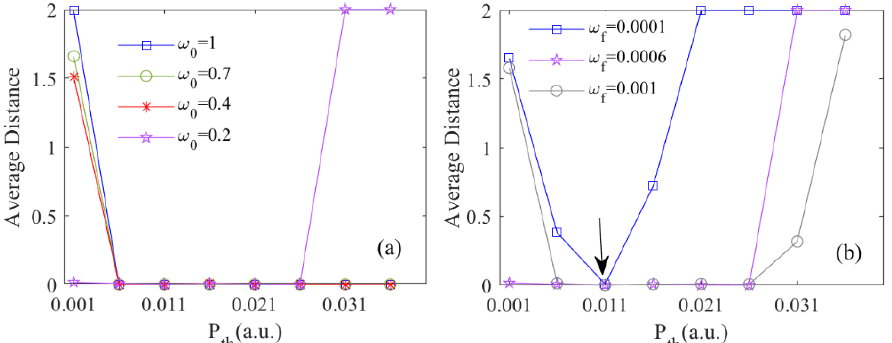
Figure 12. The average distance from epoch 201 to epoch 300 as a function of threshold power for different cases of initial weight ω 0 ( a ). The other parameters are: ω f = 0.0006, P t = 0.0032; The average distance as a function of P t with ω f = 0.0001,0.0006, and 0.001, respectively ( b